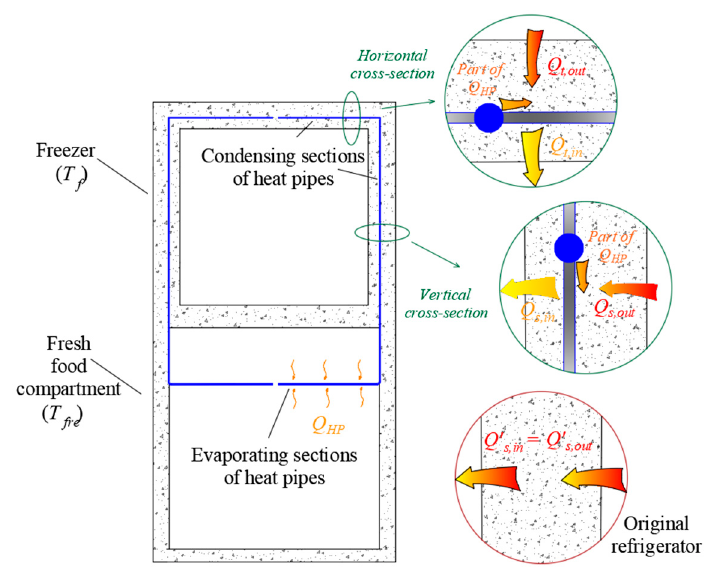
Figure 1. Section views of the improved refrigerator.